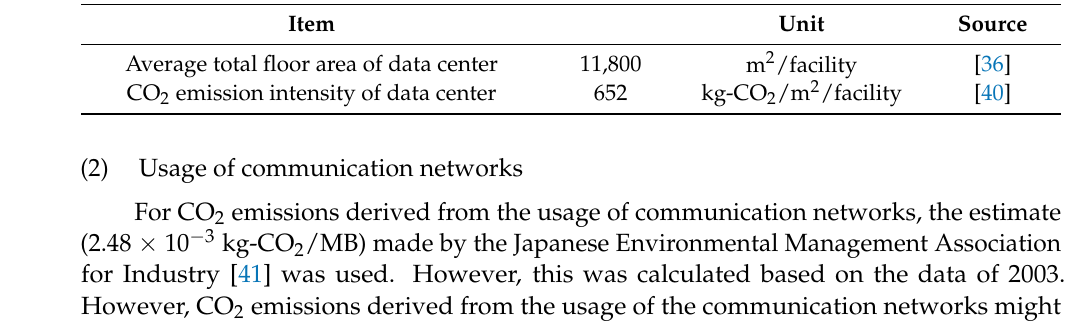
Table 2. Utilized data for usage process: usage of data